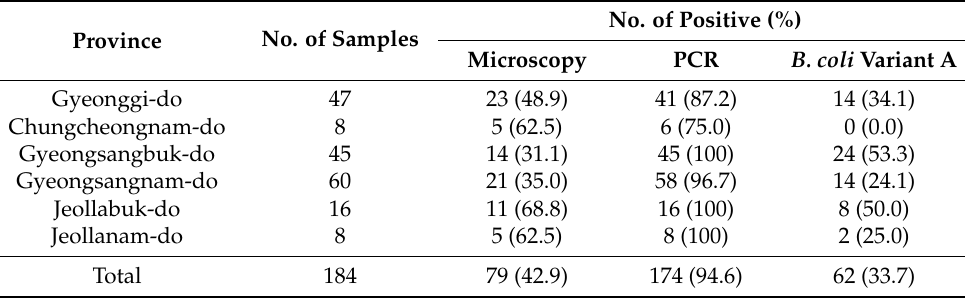
Table 2. Prevalence of zoonotic Balantioides coli in pigs in Korea according to